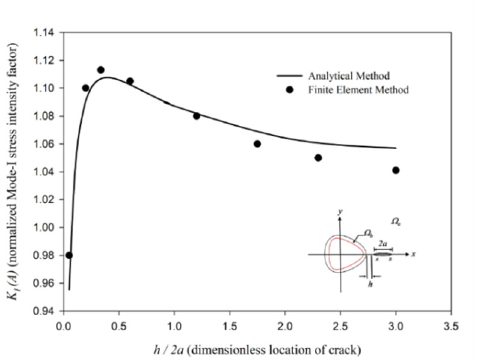
Figure 7. Stress intensity factors at Tip A for an approximately triangular hole with inclusion layer